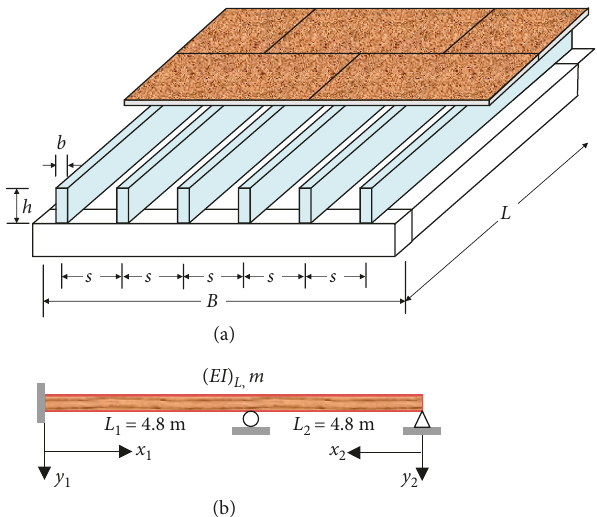
Figure 10: A two-span floor constructed from solid timber joists with fixed left end and pinned right end. (a) A two-span floor constructed with solid timber joists. (b) A two-span floor with fixed left end and pinned right end.